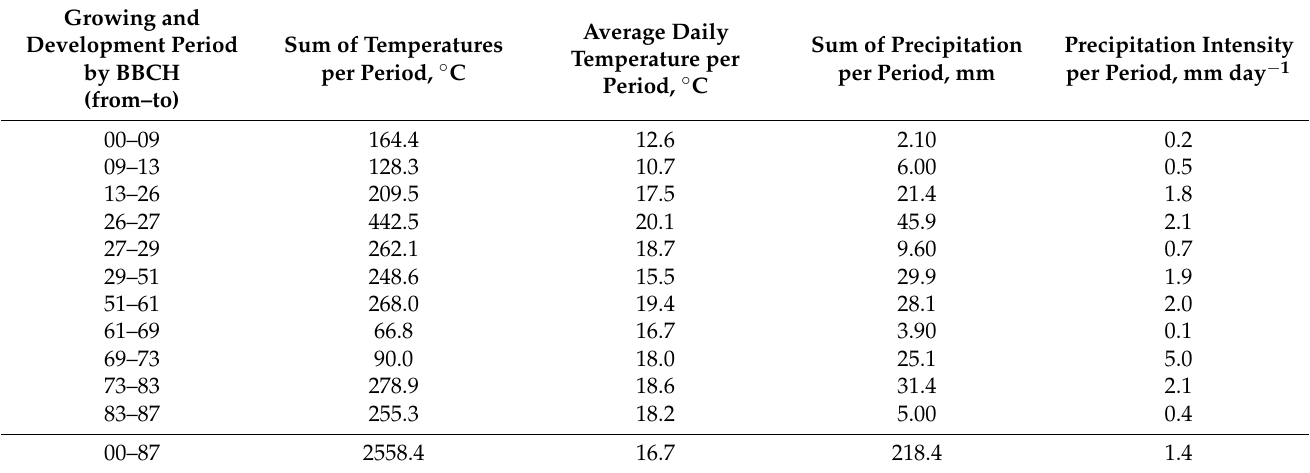
Table 3. Meteorological conditions (air temperature and precipitation) during the maize growing season in